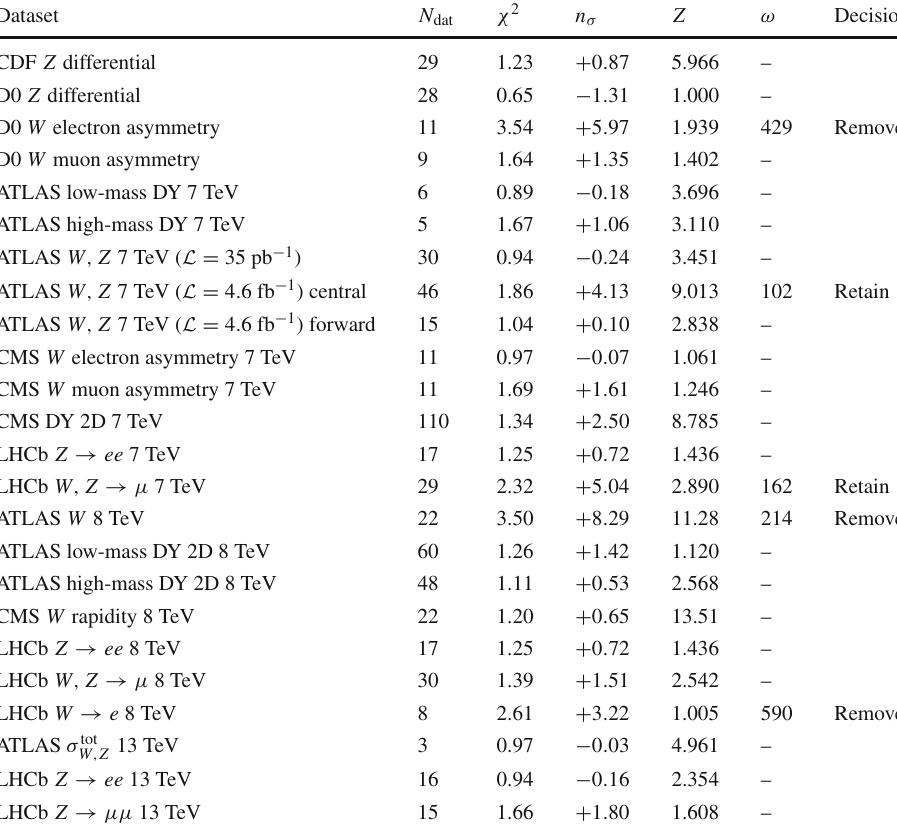
Table 14 Same as Table 12 for collider (Tevatron, top, and LHC, bottom) inclusive gauge boson production